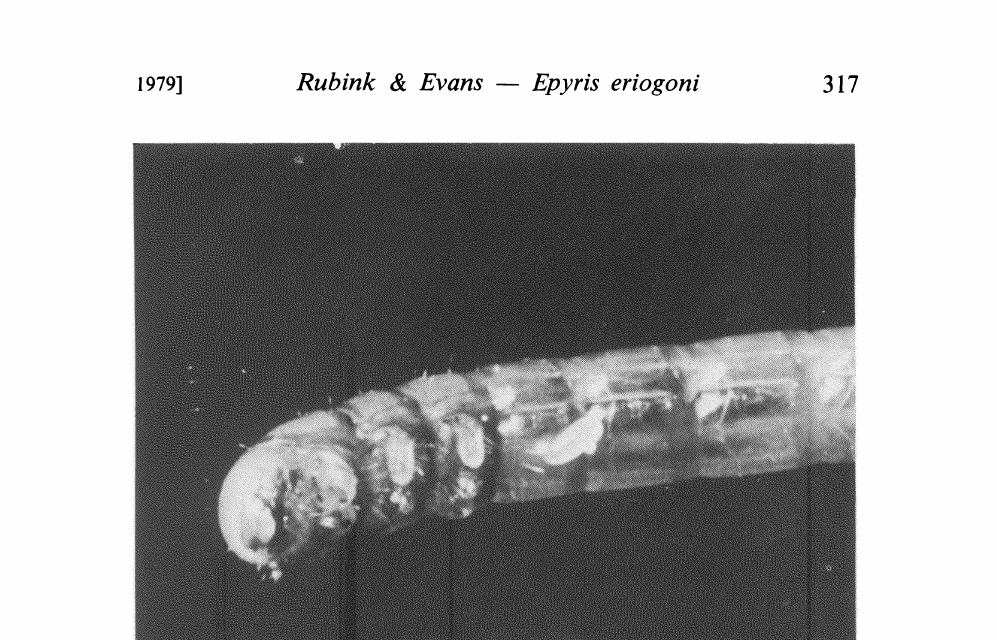
Fig. 3. Blastinus sp. larval prey of Epyris eriogoni showing egg on the first abdominal segment. (Gonocephalum seriatum (Boisduval)) Williams (1919) found to be used by E. extraneus (T. J. Spilman, pers.